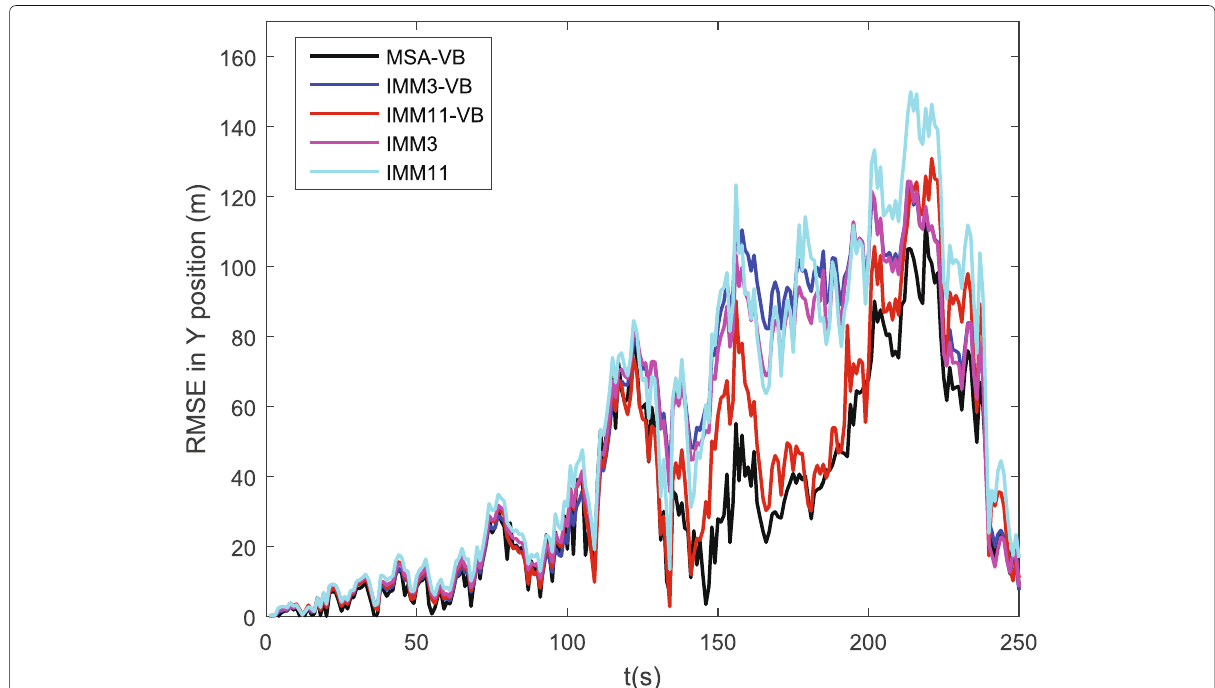
Fig. 7 RMSEs in Y position of the proposed algorithm, IMM3, IMM11, IMM3-VB, and IMM11-VB in scenario 2